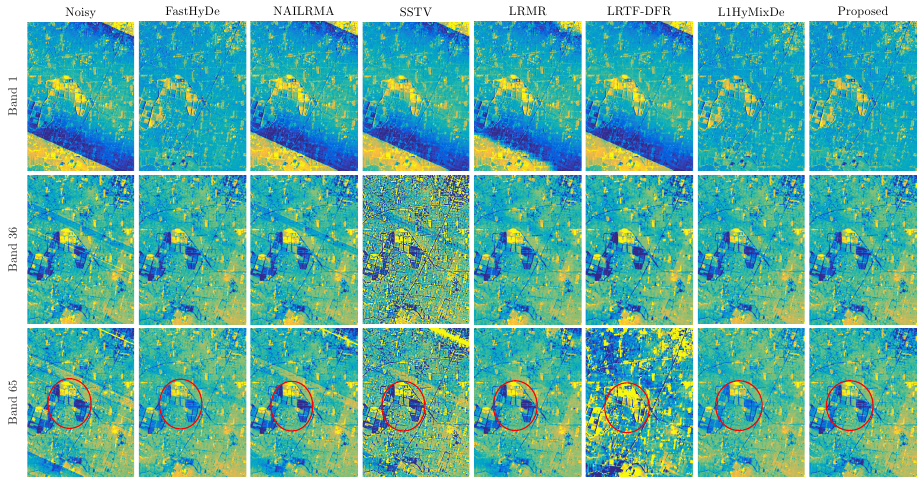
Figure 12. Bands 1, 36, and 65 of the Tiangong-1 data before and after